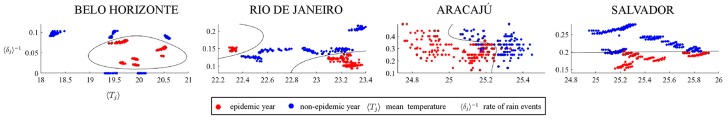
Favorable climate conditions for epidemics in predictive EP-periods.The EP strategy uses the rectangle in the t0 × p plane with earliest t0. Four capitals exhibited highly predictive EP rectangles, and we show the corresponding epidemic vs non-epidemic climate conditions. Belo Horizonte: EP-window from June 13th to August 25th. Most epidemic years had a precipitation rate in the interval [0.02,0.08] and different clusters were separated by an ovoid-shape kernel. Rio de Janeiro: EP-window ranged between June 19th and September 25th. Most epidemic years had average temperatures above 23° Celsius and precipitation rates below 0.15. Clusters were separated by an hyperboloid-shape kernel. Aracajú: EP-window from June 1st–19th. There is a clear separability between dengue and no-dengue regarding a temperature threshold around 25.2° Celsius. Clusters were separated by an S-shape kernel. Salvador: EP-windows from August 30th–December 11th. Clusters were separated by a single linear threshold of 〈δi〉−1 below 0.2. The picture shows climate signatures considering training years 2003–2012 for Rio de Janeiro and 2002–2011 for the other capitals.